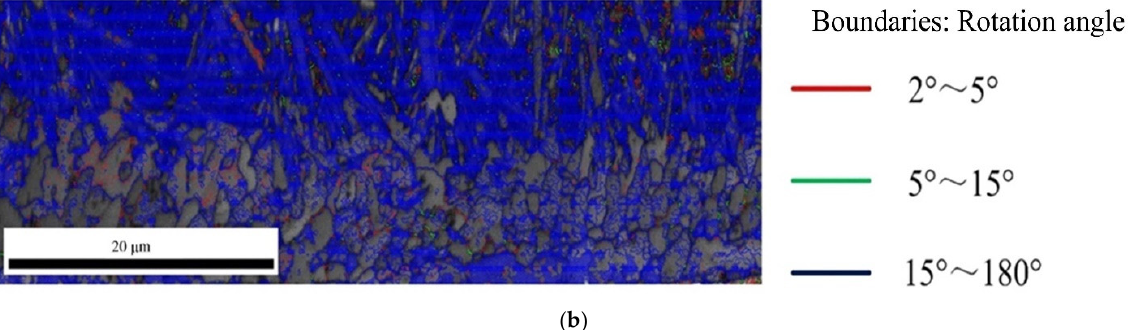
Figure 10. Angle distribution of grain boundary: ( a ) grain boundary in Fe 2 Al 5 phase and ( b ) grain boundary in Fe 4 Al 13 phase.